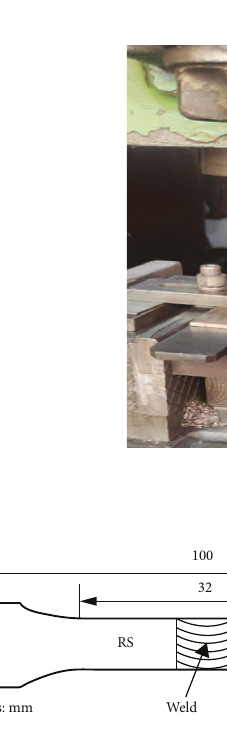
Figure 3: Schematic representation of the tensile sample.